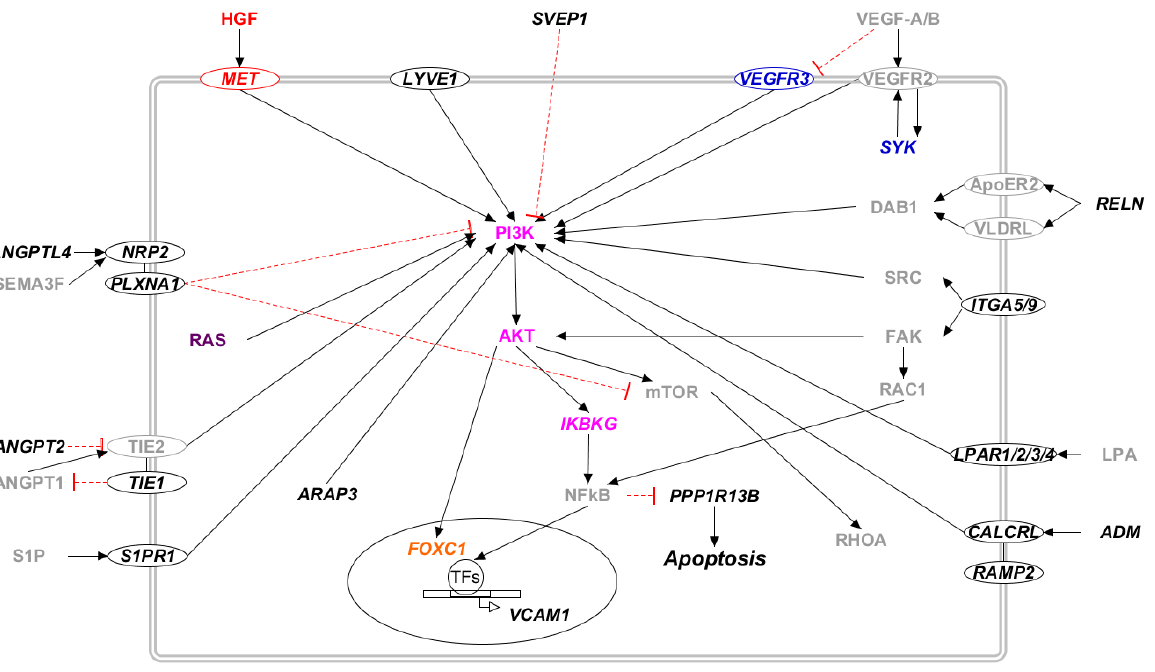
Figure 3. The PI3K/AKT pathway in candidate genes for primary lymphedema. Proteins that par- ticipate in one of the previously reported molecular pathways are colored: RAS/MAPK (violet), PI3K/AKT (lilac), VEGF-C/VEGFR-3 (blue), and HGF/MET (red). The transcription factors are